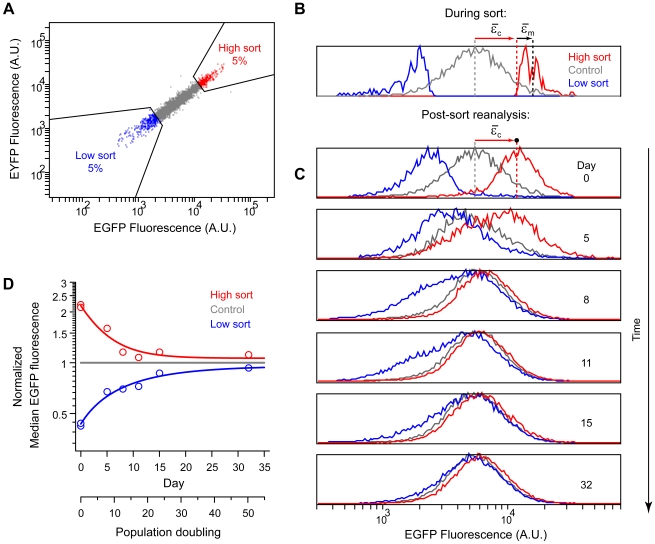
Measurement noise and dynamic response of sorted subpopulations.A) High (red) and low (blue) subpopulations (top and bottom 5% of expressing cells, respectively) were sorted from the clone (5H6) by FACS along with a control population (gray, all expressing cells, including high and low). Fluorescence in arbitrary units (A.U.). B,C) EGFP fluorescence distributions of sorted subpopulations were monitored over time (in the presence of selection). Average deviations due to cell variation () and measurement noise () in the high subpopulation are indicated by red and black arrows, respectively. Measurement noise was estimated to be ∼30% of total variation (Methods). The low subpopulation and EYFP channel yielded similar estimates (not shown). Data is from two independent sorting runs. Fluorescence in arbitrary units (A.U.). D) Median fluorescence for each subpopulation was normalized to the control and plotted as a function of time (open circles). Relaxation half times () were estimated by fitting a first order exponential decay (lines).  (high sort) = 3 days (∼5 generations);  (low sort) = 7 days (∼11 generations). EYFP similar (not shown).